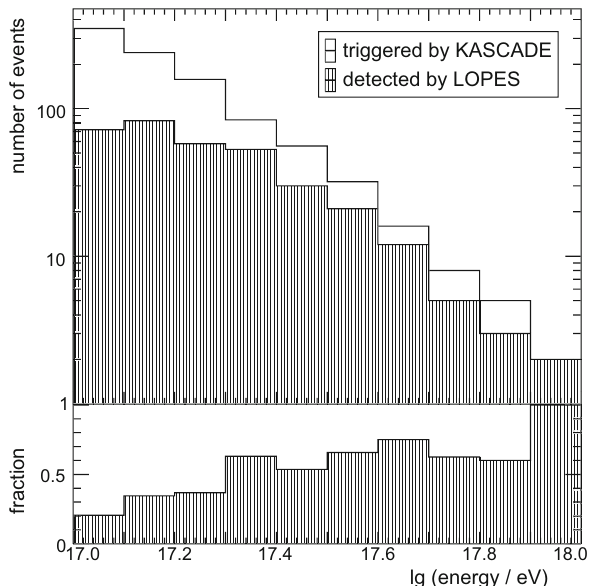
Fig. 9 Top: Number of events triggered by the KASCADE array with a reconstructed energy above 10 17 eV (no event had an energy above 10 18 eV); and the number of events in the subset passing all LOPES quality cuts. Bottom: Fraction of the two event numbers which is a measure for the efficiency of